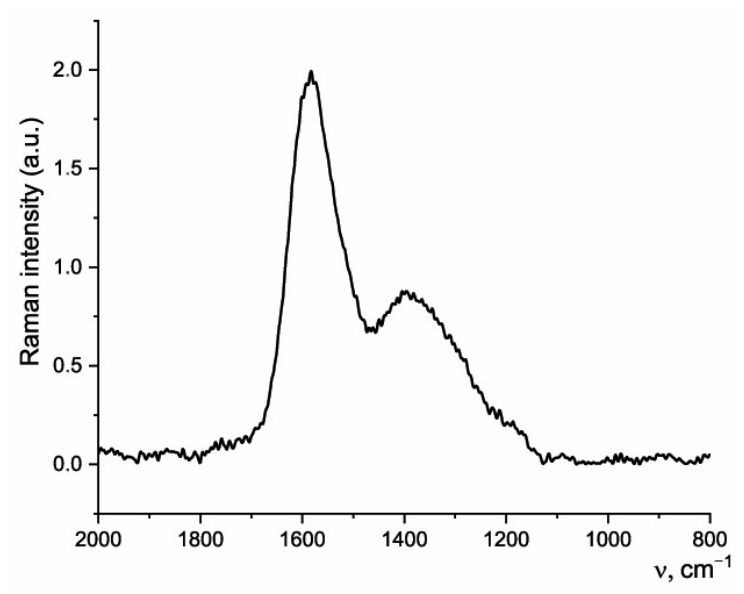
Figure 5. Raman spectrum of biochar.